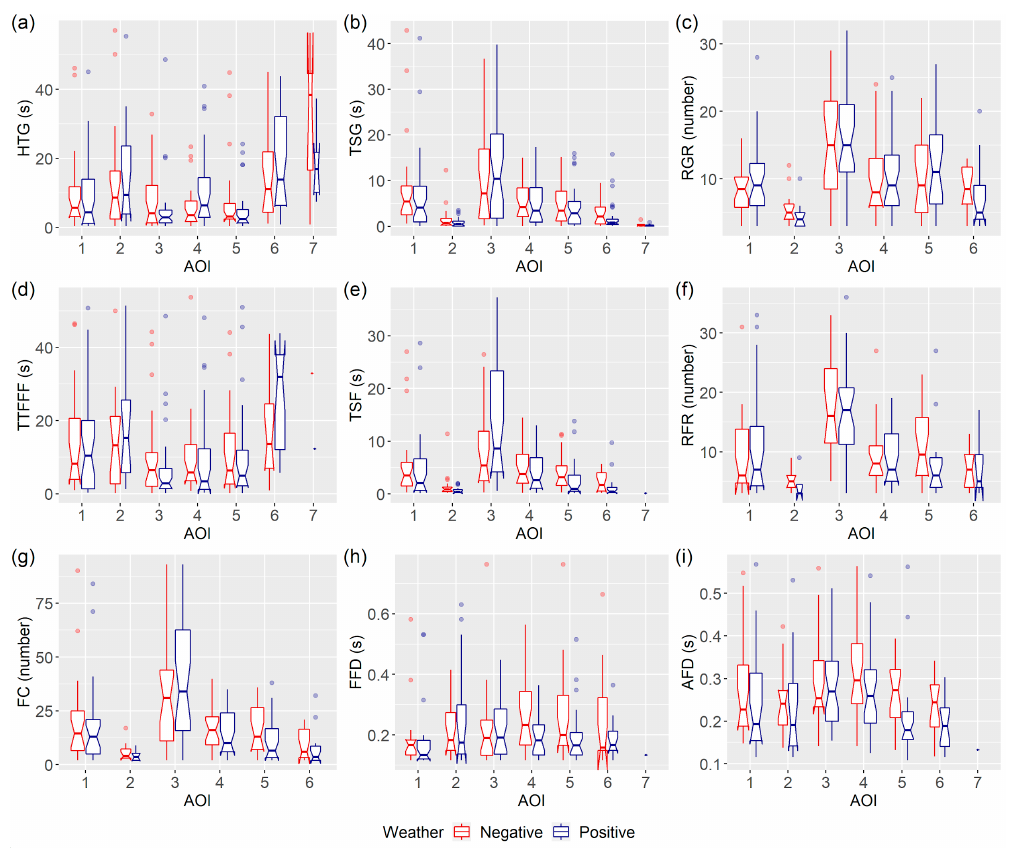
Figure 5. Statistic of chosen indexes: ( a ) HTG, ( b ) TSG, ( c ) RGR, ( d ) TTFFF, ( e ) TSF, ( f ) RFR, ( g ) FC, ( h ) FFD, ( i ) AFD (detailed description of indexes in the research area, data and methods chapter) for particular AOI in negative and positive weather for respondents with a bad frame of mind (boxplots description according to Figure 3).